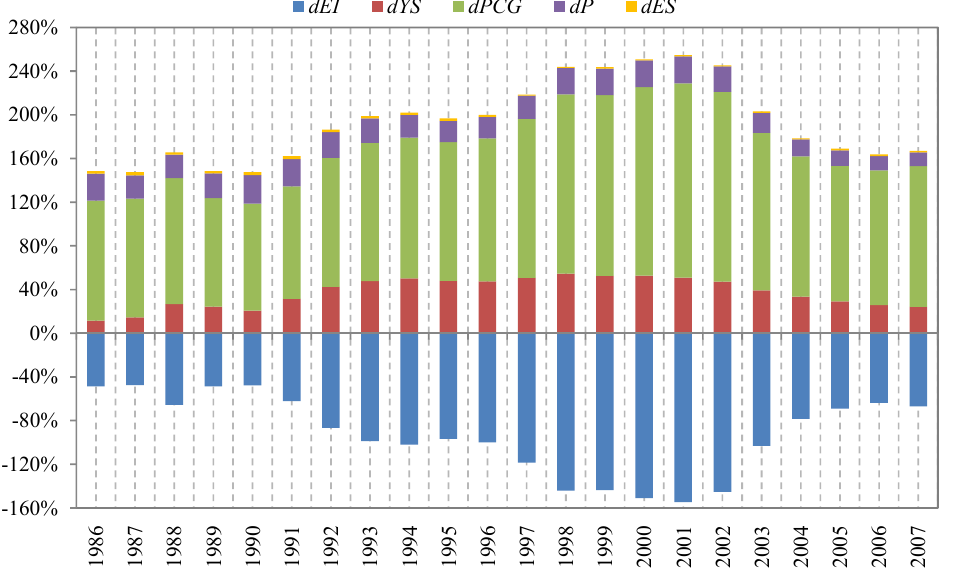
Figure 5. Cumulative contribution rates of influencing factors of the energy-related industrial CO 2